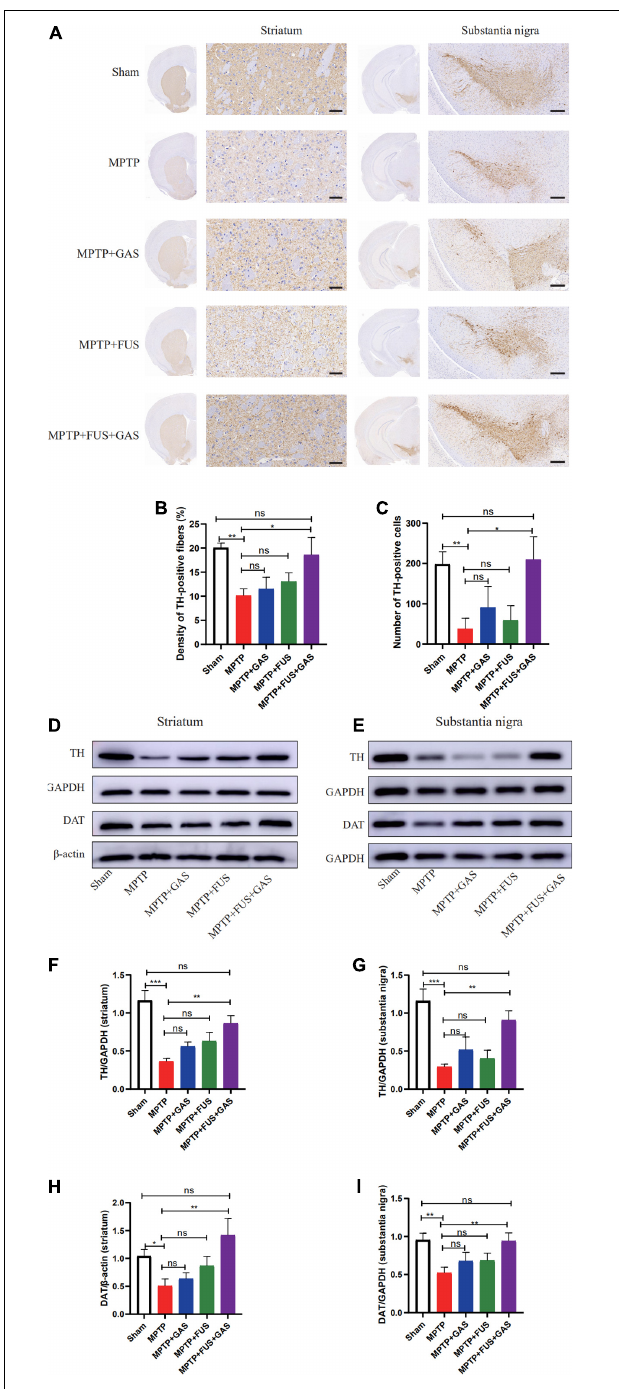
FIGURE 4 | (A) Comparison of the immunohistochemical staining of tyrosine hydroxylase (TH)-positive nerve fibers in the left striatum and substantia nigra of mice in each group, n = 3. Scale bars = 50 µ m for images in stratum; 200 µ m for images in substantia nigra. (B) Changes of TH-positive nerve fibers in the left striatum of mice in each group. (C) Number changes of TH-positive cells in the left substantia nigra of mice in each group. (D,E) Representative images of the protein levels of TH and Dopamine transporter (DAT) in the left striatum and substantia nigra of mice in each group.